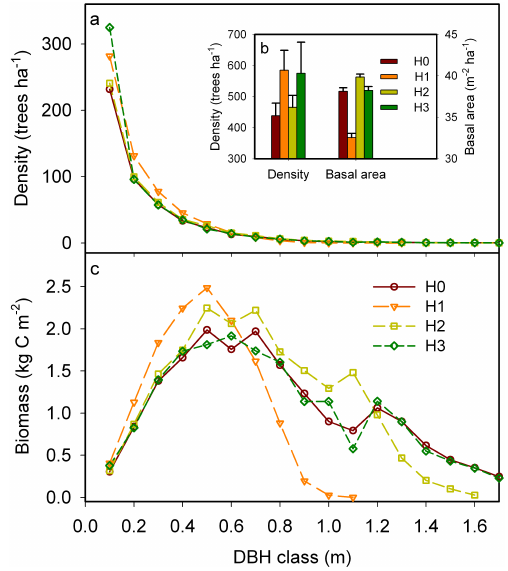
Figure 6. Simulated distributions of tree size and biomass at quasi- equilibrium in one-species ( Acer saccharum ) LM3-PPA simulations under alternative models assumptions (H0–H3). Size and biomass distributions are averaged over the last 400 years of 1000-year sim- ulations. (a) Tree density of trees in 10cm DBH bins. (b) To- tal tree density and basal area, summed over the size distribu- tion in panel (a) . The error bars represent one standard deviation. (c) Woody biomass in 10cm DBH bins. Different colors in the fig- ure refer to differ alternative model assumptions (see Table 2 and Fig. 1 for details): H0 is the baseline LM3-PPA model; H1 assumes that mortality rate increases with size for large trees; H2 assumes a maximum individual crown area, which causes a decline in DBH growth rate for large trees; and H3 assumes that open canopy space is filled by randomly chosen understory trees rather than the tallest understory trees as in the PPA model.